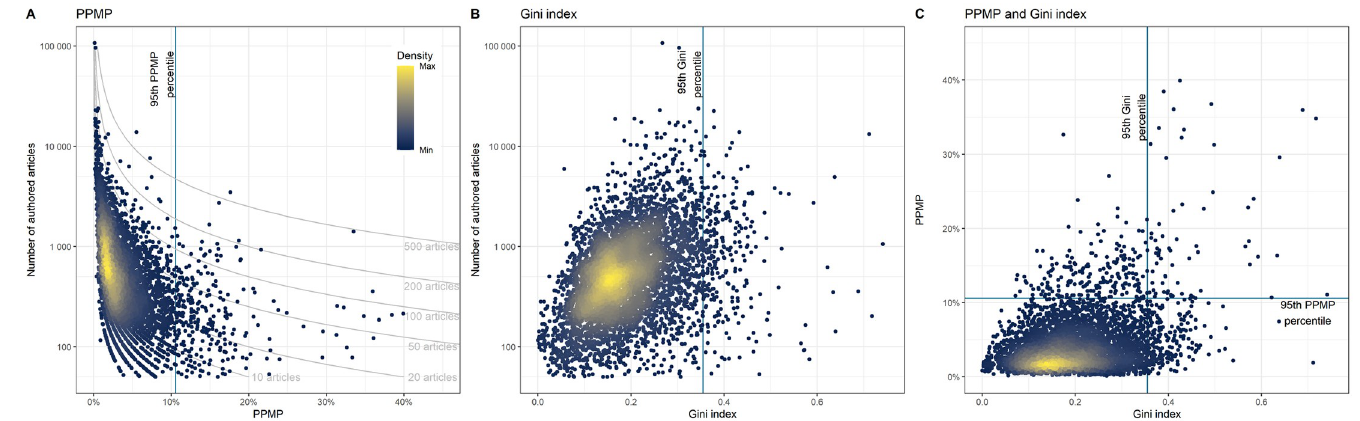
Fig 2. PPMP and Gini index among all articles. Distribution of PPMP author(s) (A) and Gini index (B) in relation to journal size, and comparison between the PPMP and the Gini index (C), across all articles published by all journals in the United States NLM catalog having at least one Broad Subject Term and having published at least 50 authored articles between 2015 and 2019. The data underlying this figure may be found in https://osf.io/6e3uf/. NLM, National Library of Medicine; PPMP, Percentage of Papers by the Most Prolific author.